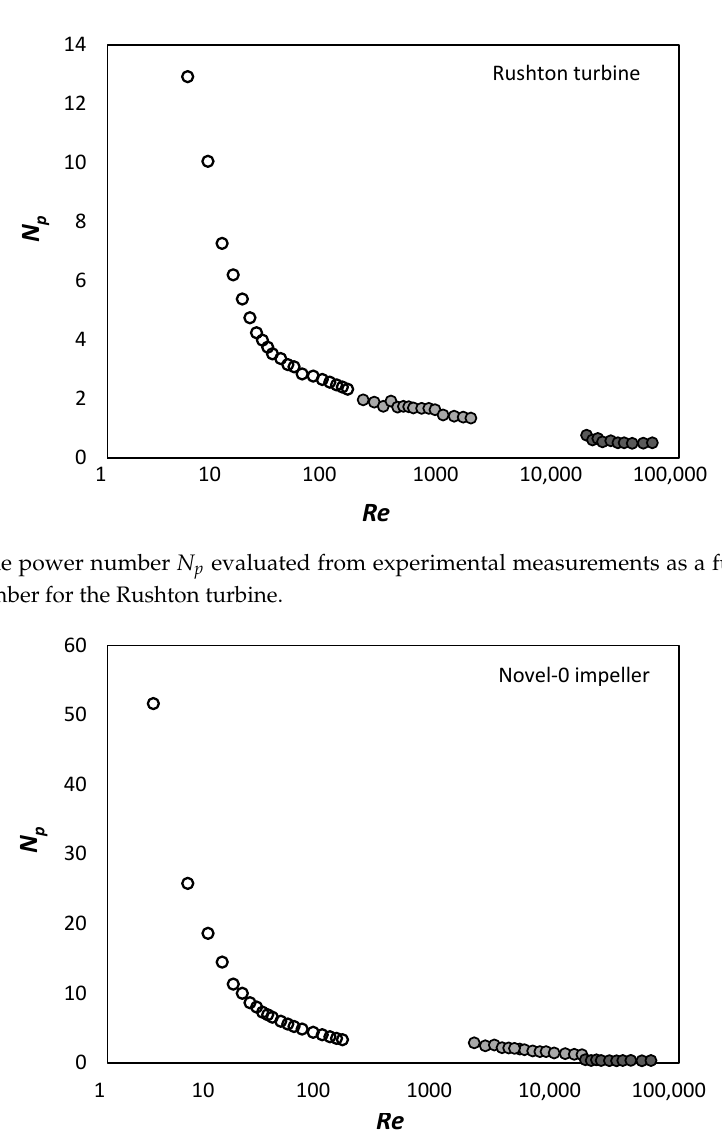
Figure 12. The mixing efficiency evaluated from experimental measurement for the Rushton turbine and different distances from the tank bottom.